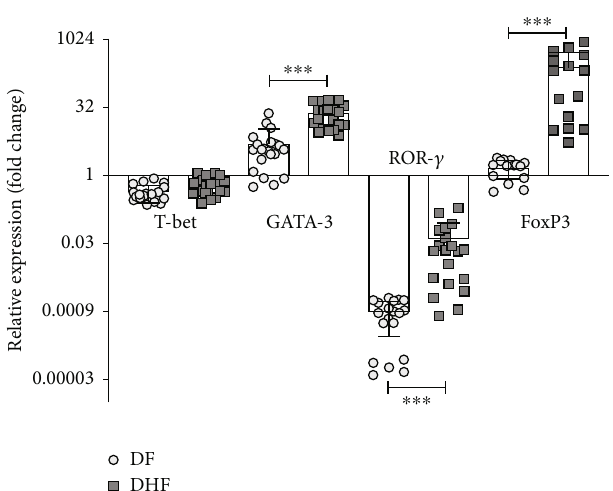
Figure 4: Relative gene expression analysis of T cell transcription factors. The expression of T-bet (Th1), GATA-3 (Th2), ROR- γ (Th17), and FOXP-3 (Treg) was analyzed ex vivo in PBMC of DF and DHF patients; data are expressed as fold increments compared with the expression level of the control group, which was assigned an arbitrary value of 1. Error bars represent mean ± SD . Signi fi cant di ff erences ∗ p < 0 : 05 , ∗∗ p < 0 : 01 , and ∗∗∗ p < 0 : 001 by the Mann – Whitney U test.